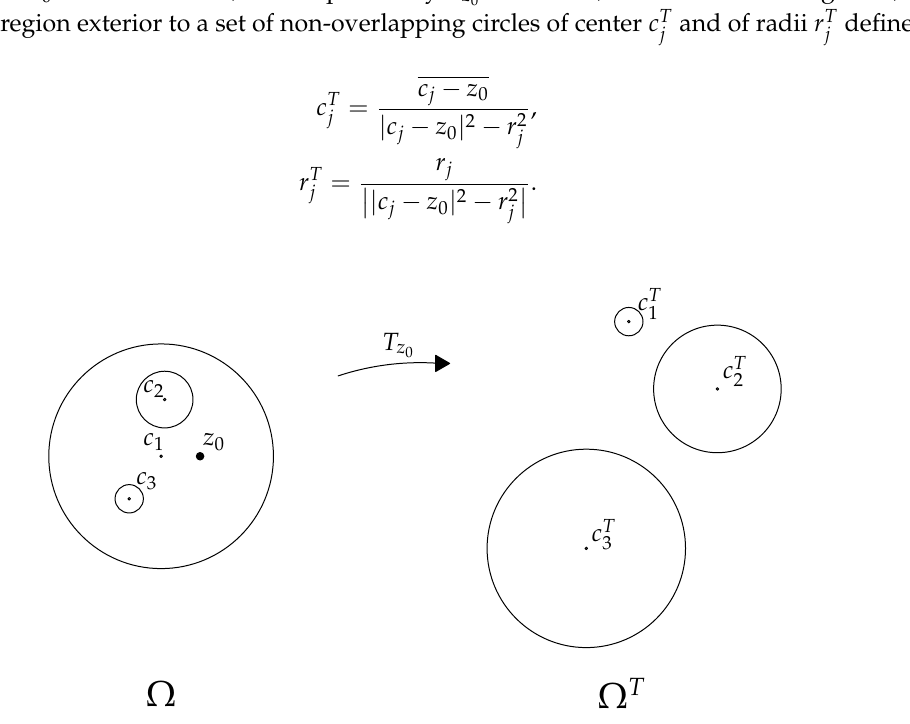
. Ω T is the space exterior to three 0